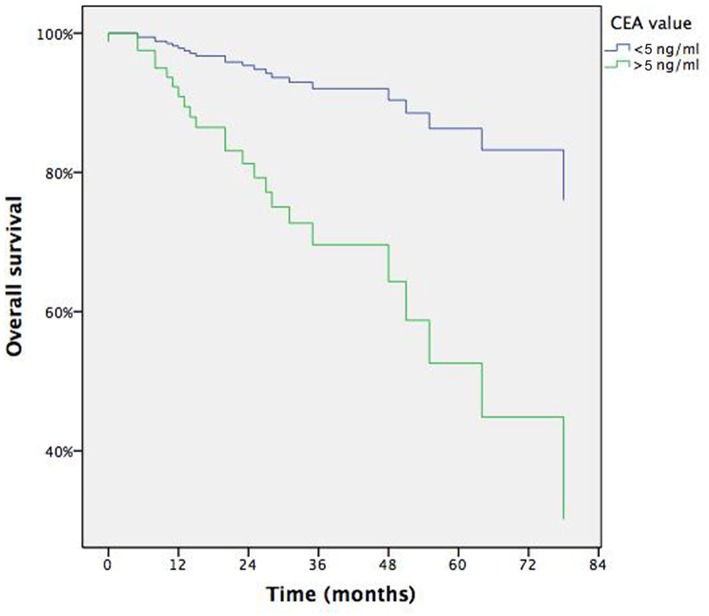
Survival according to CEA at means of covariates.